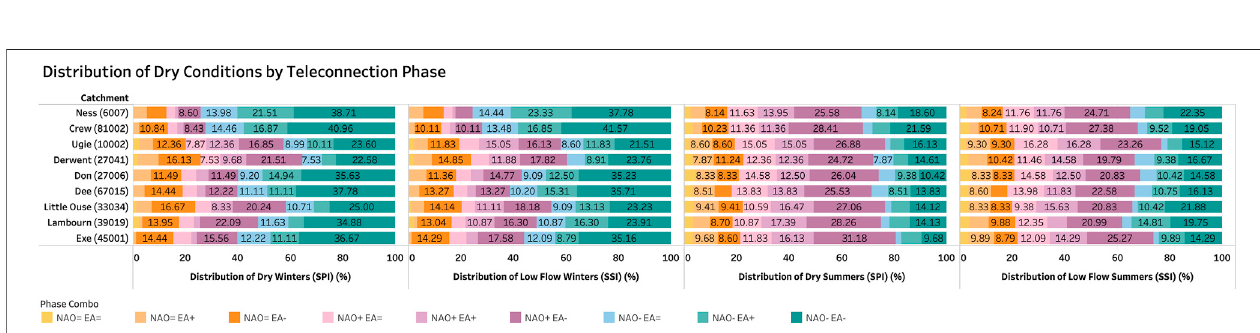
FIGURE9| Distribution ofdryevents(negativeSPI-1andSSI-1values)underdifferentphasecombinationsoftheNAO andEAforthewinterandsummermonths. Values represent the percentage of time dry events occur under the different phase combinations.